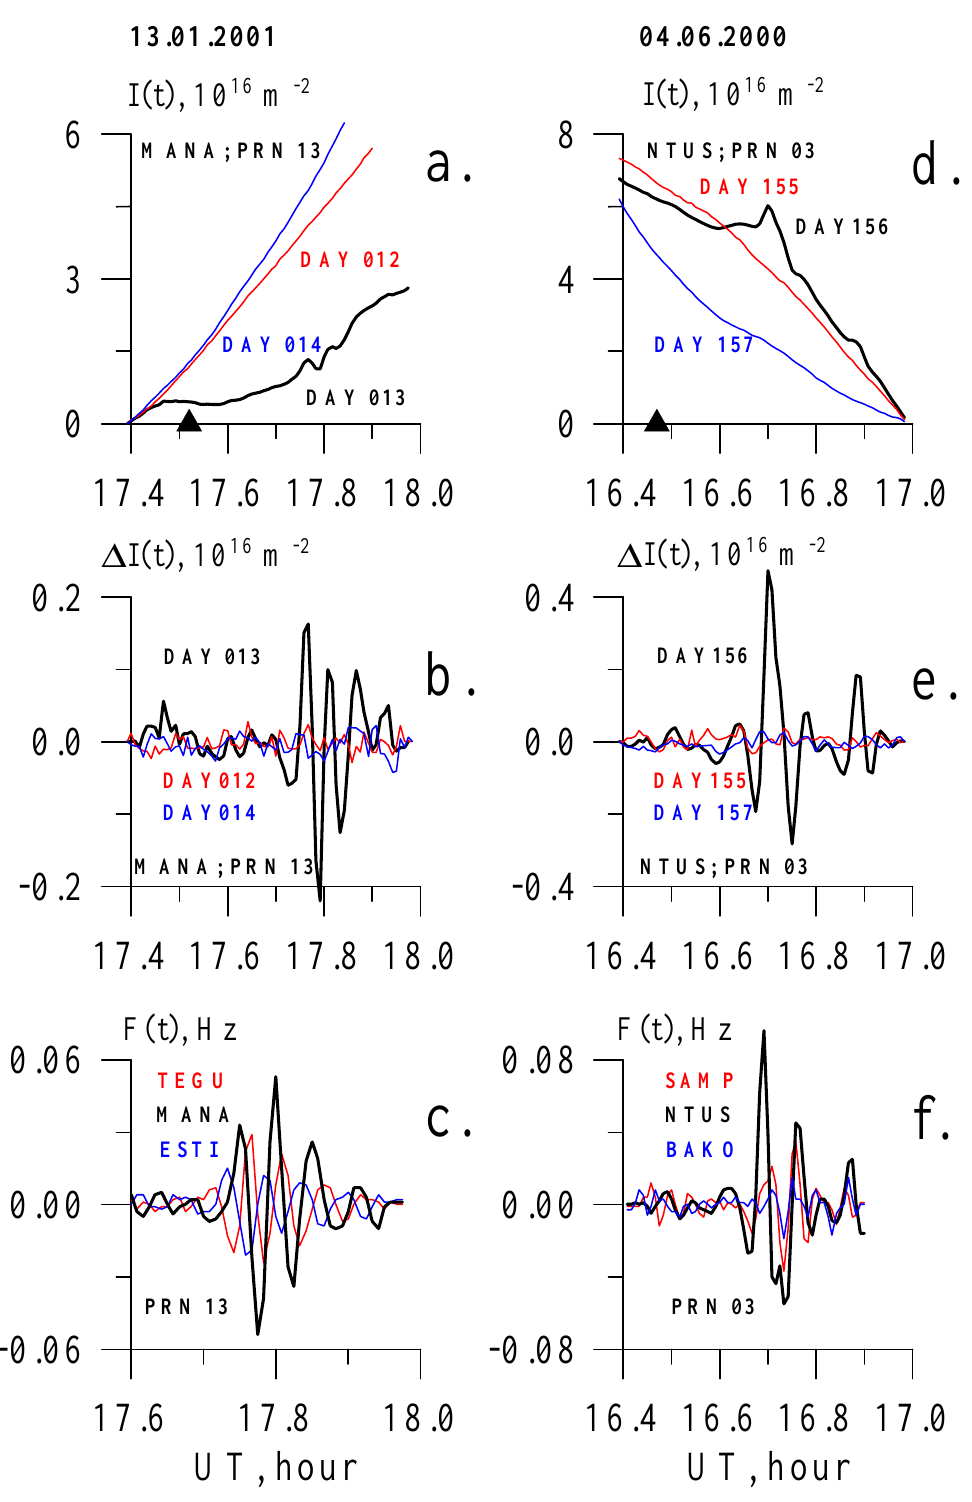
Fig. 3. Same as in Fig. 2, but for the earthquakes off the coast of Central America, 13 January 2001 – at the left, and in Southern Sumatra, 4 June 2000 – at the